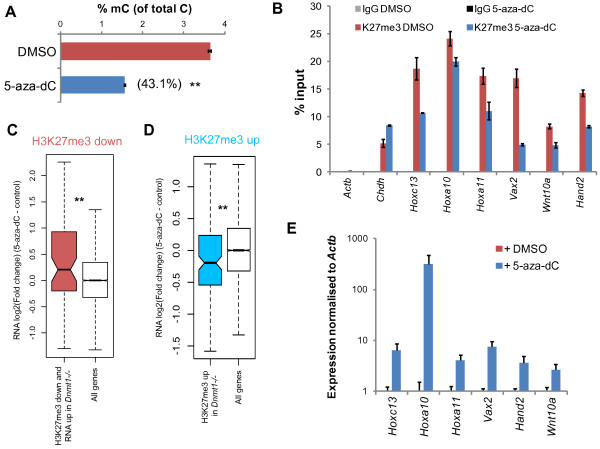
Demethylation with a DNA methyltransferase inhibitor results in redistribution of H3K27me3. (A) Global quantification of the 5mC base by HPLC. Values are 5 mC as a percentage of total C in Dnmt1+/+ MEFs treated with vector control or 5-aza-dC. Error bars represent standard error of the mean (SEM). **P <0.001 by t-test. (B) ChIP-qPCR for H3K27me3 in Dnmt1+/+ MEFs treated with vector control or 5-aza-dC using primers for the promoters of the indicated genes. Enrichment for each immunoprecipitation (IP) is expressed as percentage of DNA in input. Non-specific IgG IP and the Actb promoter are shown as negative controls and the Chdh promoter is shown as a positive control. Error bars indicate ±SEM of two experiments. (C, D) Boxplots showing the relative expression (log2) of the indicated gene set, and all genes, between vector control and treatment with 5-aza-dC in Dnmt1+/+ MEFs. The gene sets compared are those that are both H3K27me3 down and >1.5 fold upregulated at mRNA level in Dnmt1-/- MEFs (C), and H3K27me3 up in Dnmt1-/- MEFs (D). **P <0.005 by Wilcoxon rank sum test relative to all genes. (E) qRT-PCR quantifying expression of the indicated genes in Dnmt1+/+ MEFs treated with vector control or 5-aza-dC. Expression is normalized to Actb and expressed relative to vector control. Error bars represent ±SEM of three replicates. 5-aza-dC, 5-aza-2-deoxycytidine; DMSO, dimethyl sulfoxide; IgG, immunoglobulin G.